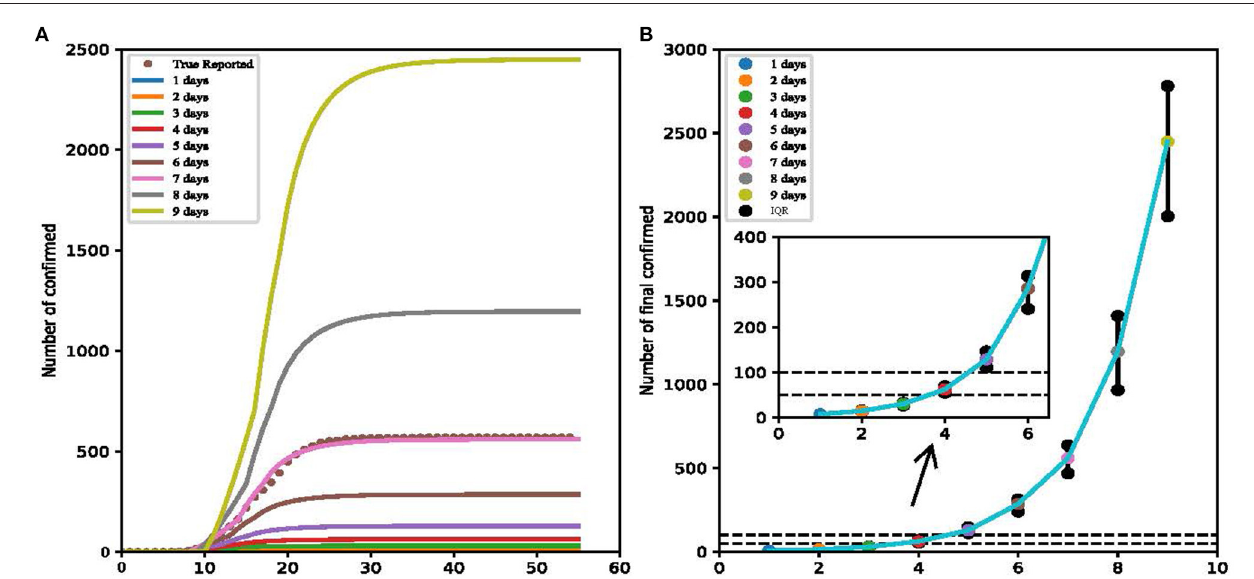
FIGURE 4 | Result of detection intervals from 1 to 9 days (Yangzhou, China, 2021). (A) The cumulate infection of nine intervals. (B) The total infection number of nine simulations.